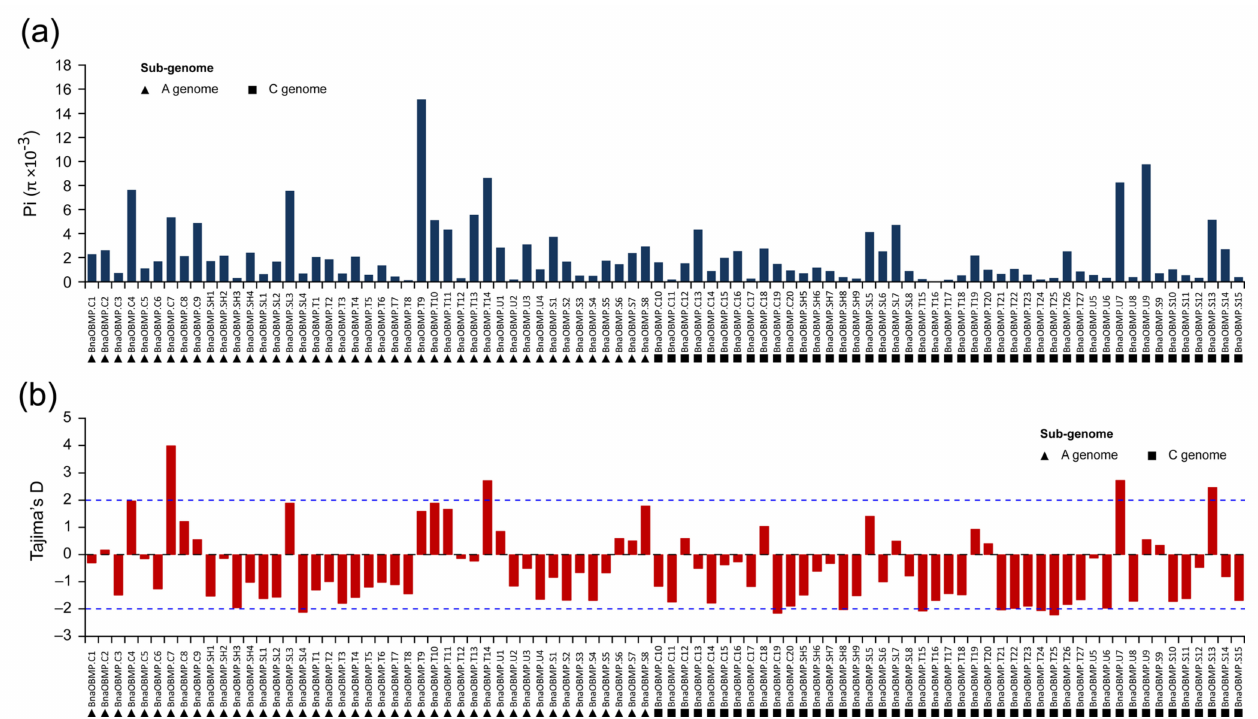
Figure 5. Observed pi ( π ) and Tajima’s D values for BnaOBMP genes. ( a ) Pi ( π ) values for each BnaOBMP gene. The black triangles and squares represent BnaOBMP genes in the A and C subgenomes of B. napus , respectively. ( b ) Tajima’s D values for the BnaOBMP genes. The BnaOBMP genes derived from the A subgenome and C subgenome are marked by black triangles and squares, respectively. The blue, dashed lines represent the cutoff of 2 and − 2. The black, dashed line represents the baseline of